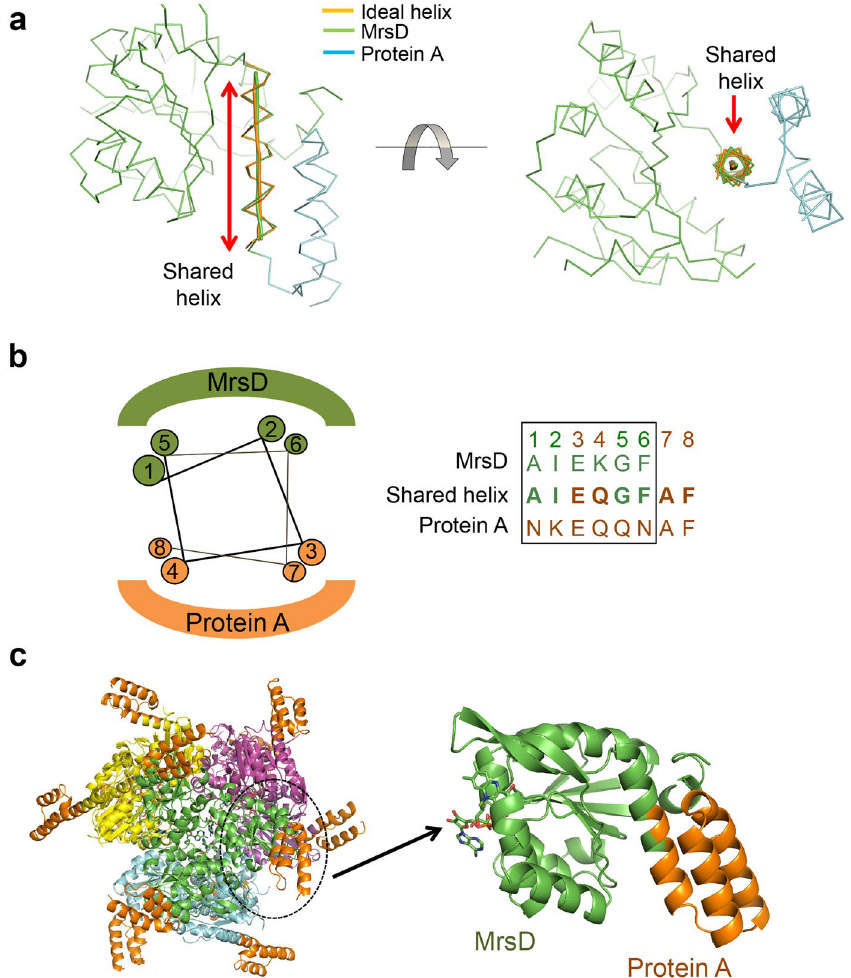
Figure 1. Fusion of MrsD and protein A by the shared helix method. ( a ) The helix docking strategy. An ideal helix from the 1RHG structure of PDB database is first docked to the C-terminal helix of MrsD. Then, the N-terminal helix of protein A is docked to the ideal helix while avoiding steric collision between the two proteins. See “Methods” for details. ( b ) The amino acid selection strategy. Amino acids of MrsD are selected for positions 1, 2, 5 and 6, whose side chains point to the hydrophobic core of MrsD. Similar residues of protein A are selected for positions 3, 4, 7 and 8. ( c ) Crystal structure of the MrsD-protein A fusion protein. A magnified view of the structure of one of the twelve subunits is shown on the right. The structure of a FAD molecule bound to MrsD is drawn as